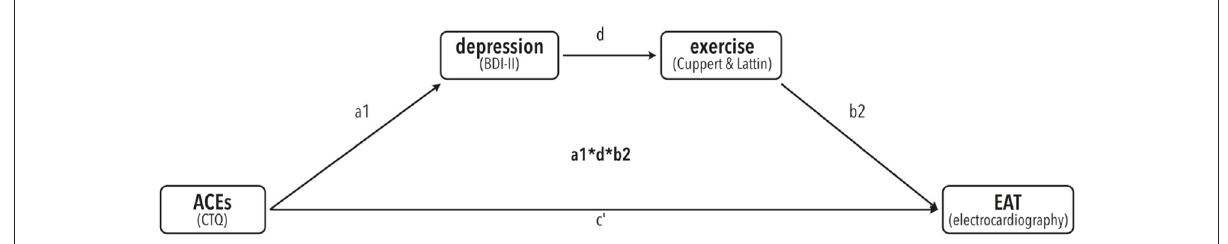
FIGURE1 A-priori proposed mediation model of the link of ACE’s (predictor) with EAT (dependent variable) via serial mediators depression (BDI-II) and exercise (Cuppett & Latin